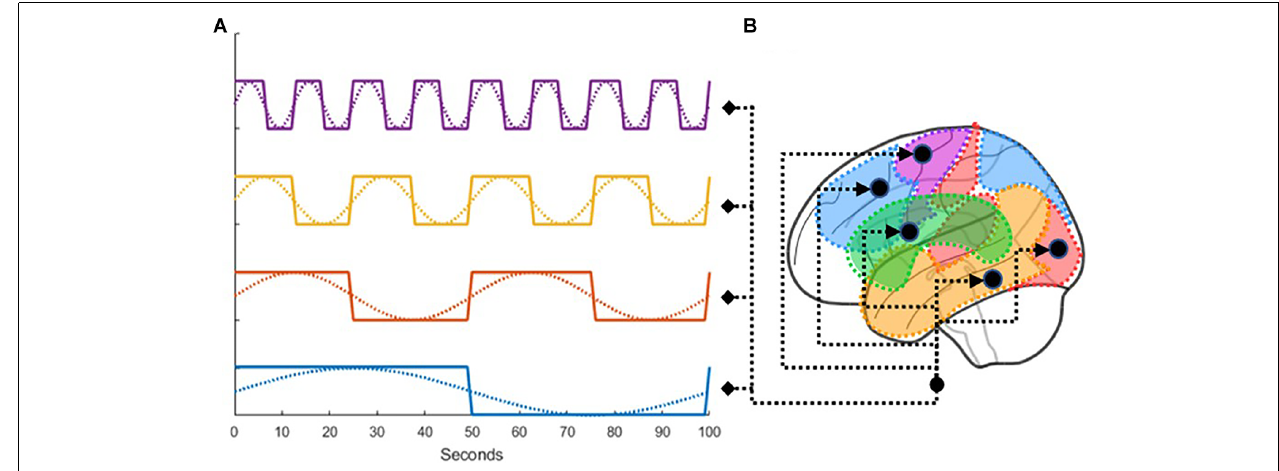
FIGURE 4 | (A) Illustration of how low-frequency fluctuations were transformed into boxcar functions, which were then (B) used as drivers for the activity in all ROIs.